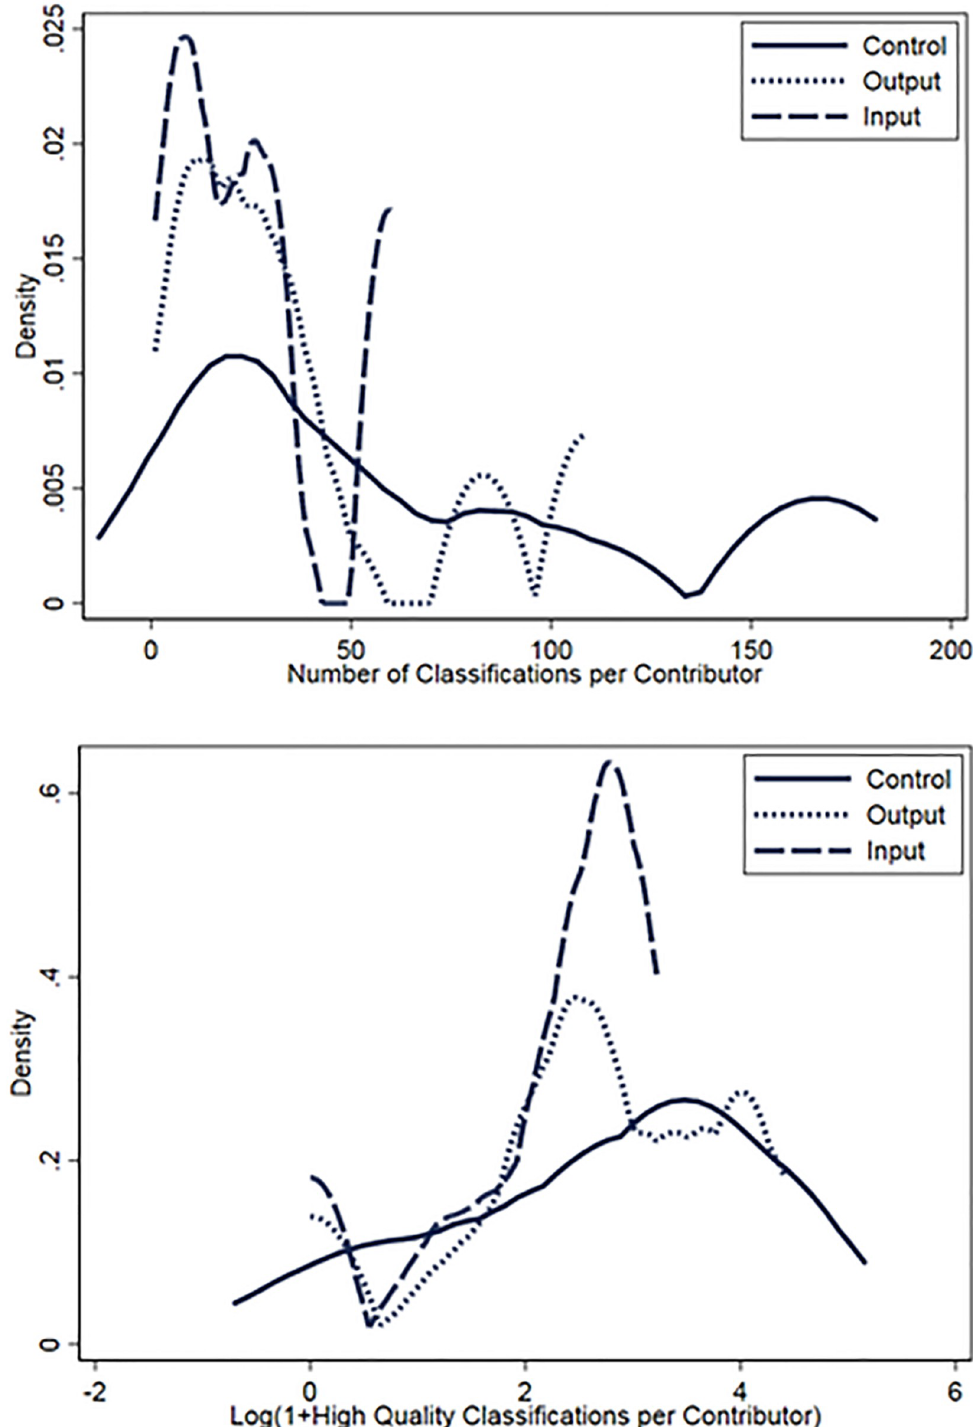
Fig 5. Kernel densities of contributor quantity and quality by treatment groups. Figure plots the Epanechnikov kernel density of the number of classifications completed per user (Panel A) and number of high quality classifications completed per user (Panel B) by treatment group. The narrower distribution plot for the treatment lines suggest that the probability of an outcome (i.e., the number of classifications completed per contributor or the number of high quality classifications) on treatment pages falls under a tighter band compared to the